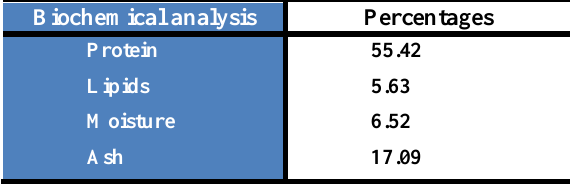
Table, 3: Percentages of commercial fish meal biochemical